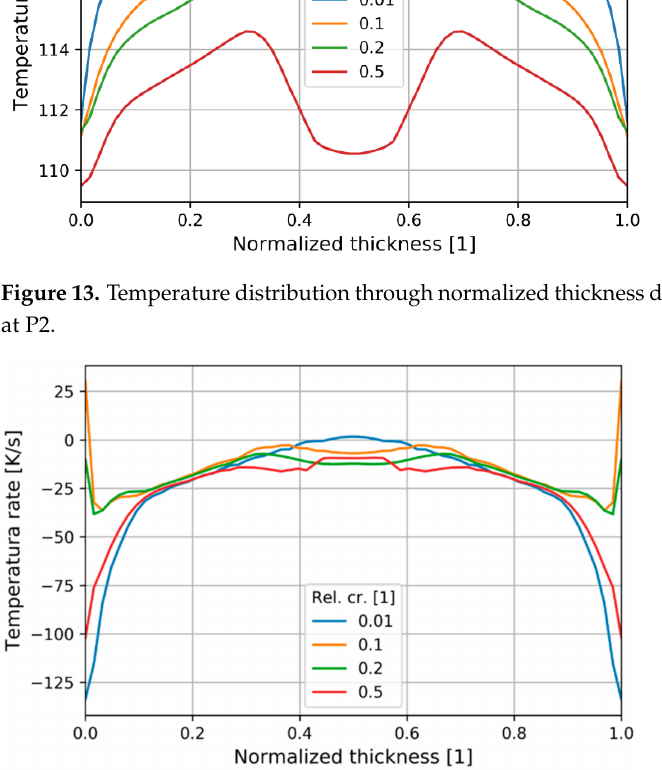
Figure 14. Temperature rate distribution through normalized thickness depending on relative crystallinity at P2.